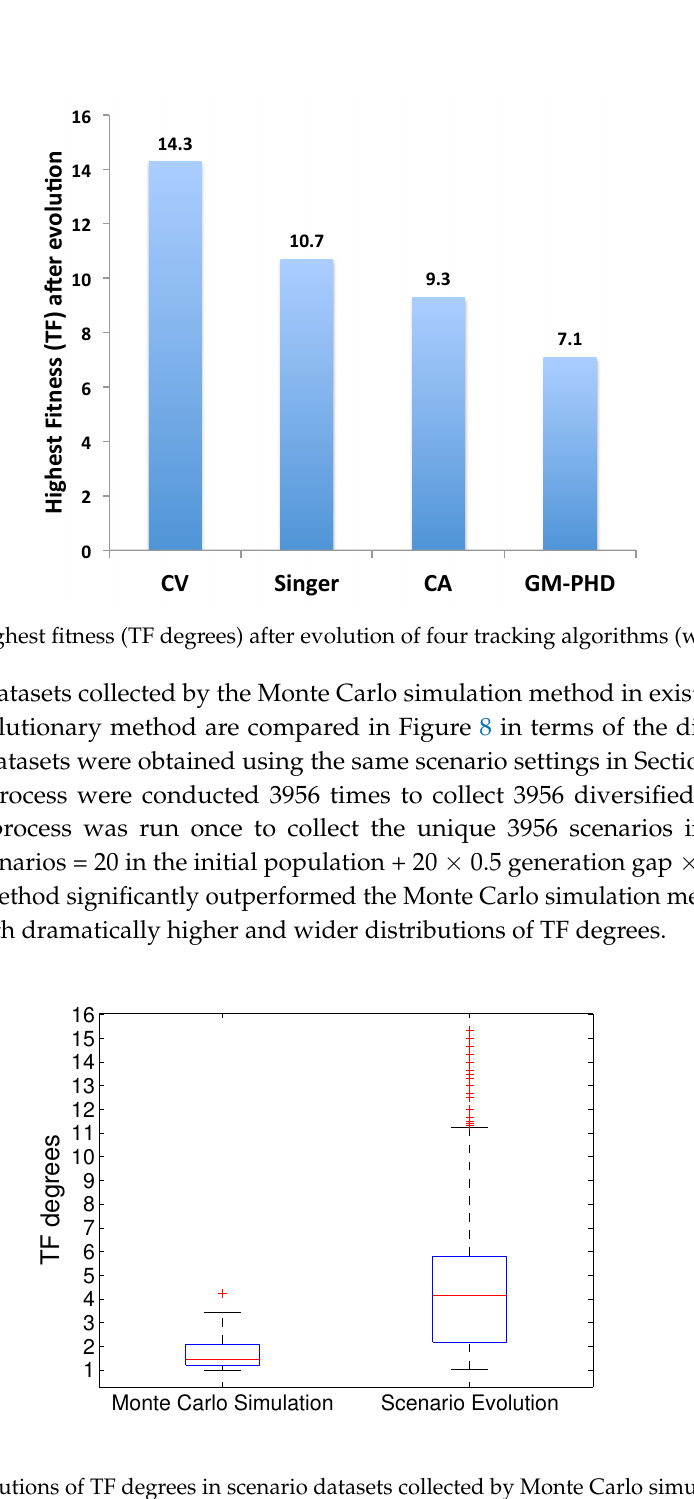
Figure 8. Distributions of TF degrees in scenario datasets collected by Monte Carlo simulation method and our evolutionary